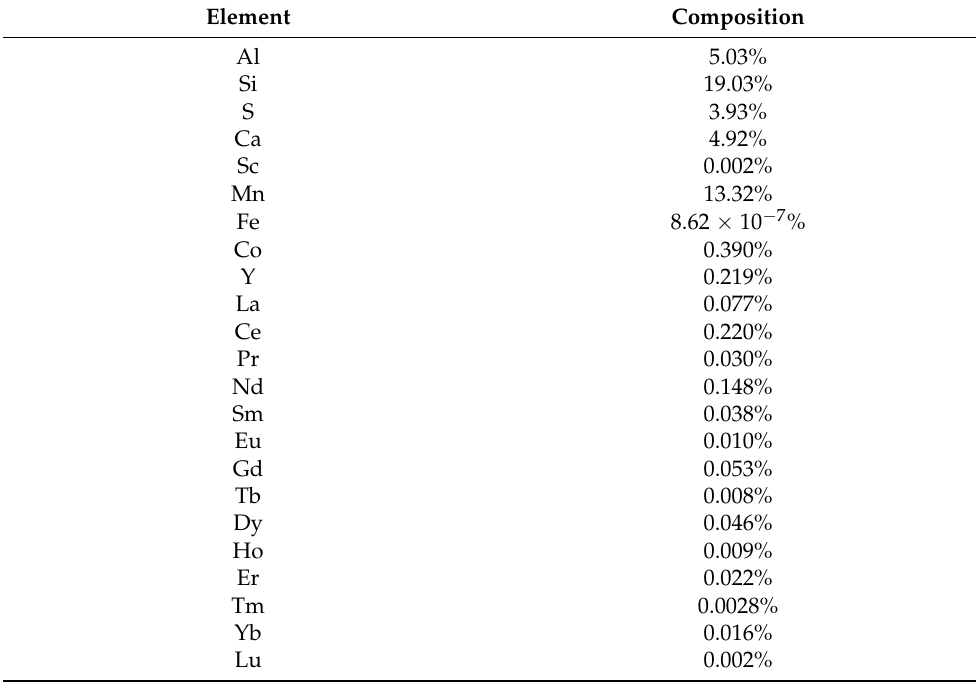
Table 4. Pre-concentrate composition.